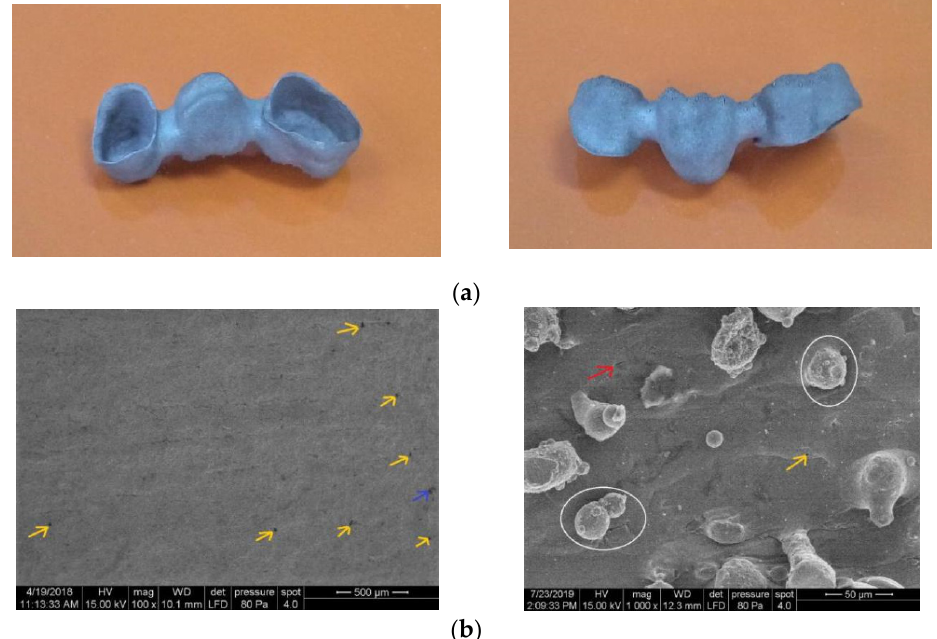
Figure 11. ( a ) SLM-manufactured dental bridge using optimal process parameters established for 316L powder; ( b ) SEM images of surface morphology (×100 and ×1000 magnification).